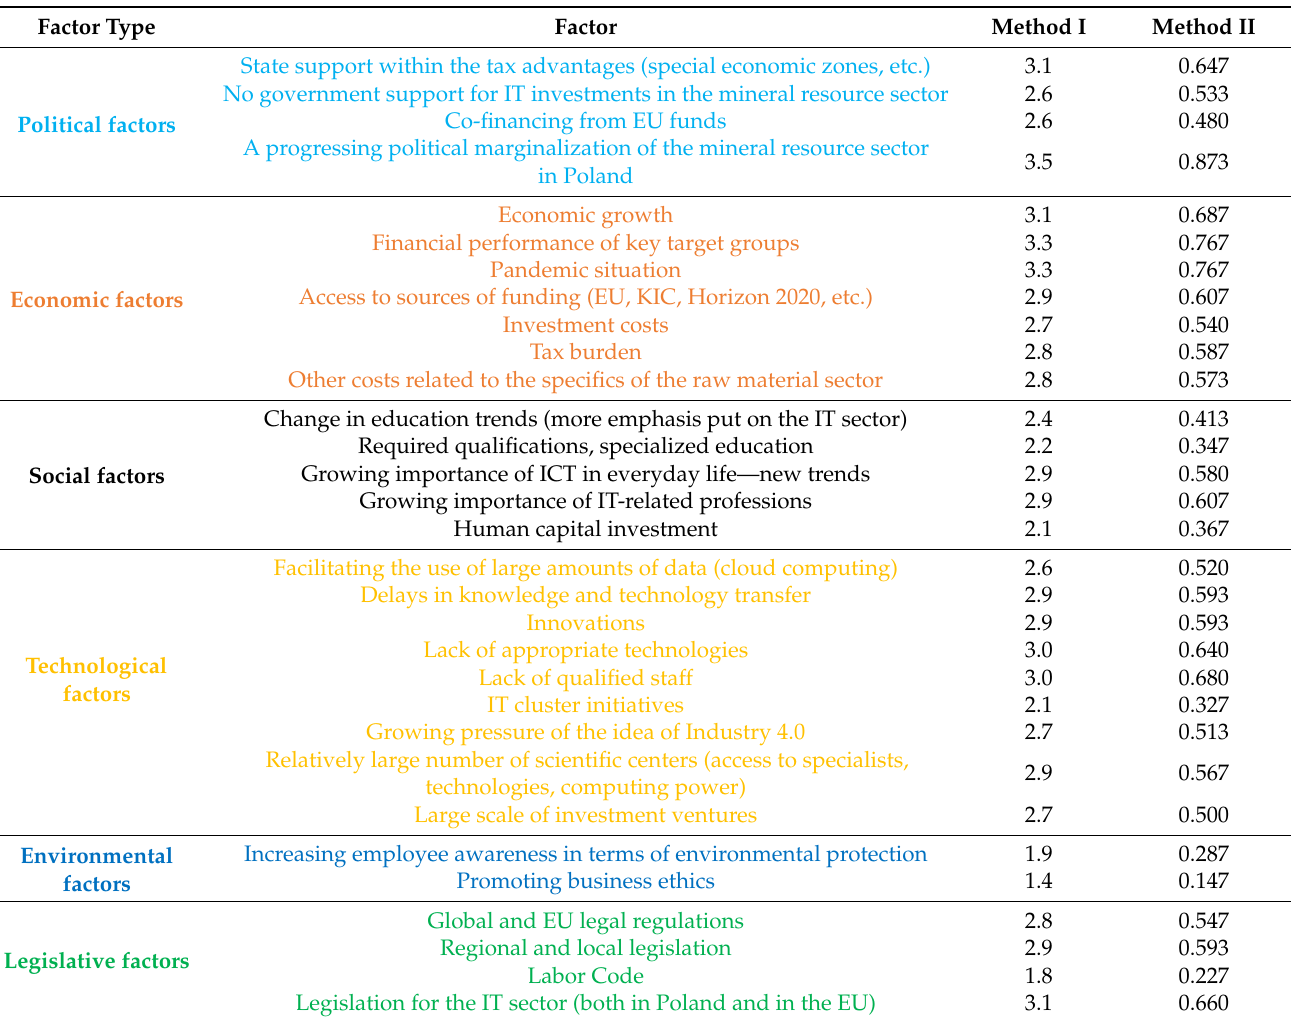
Table 2. The results of the analysis of the statistical dominance of factors in six